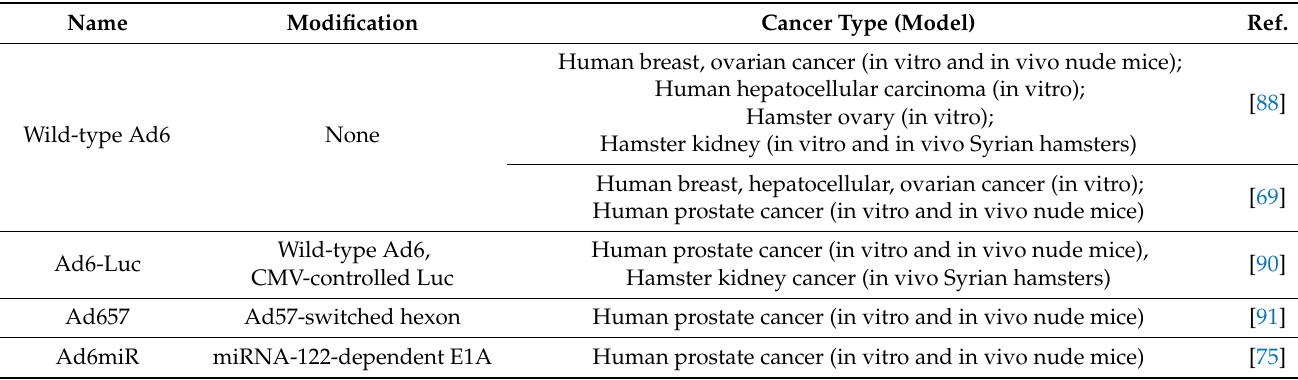
Table 1. Ad6-based oncolytic vectors.